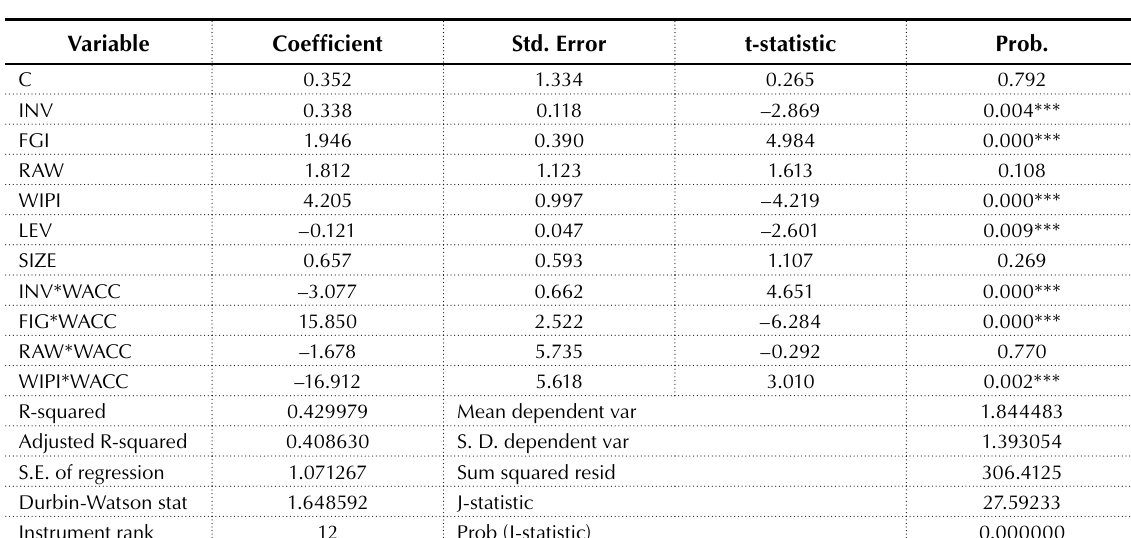
Table 6. Inventory types, cost of capital and firm